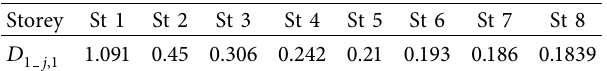
′ for 20cm wall 1